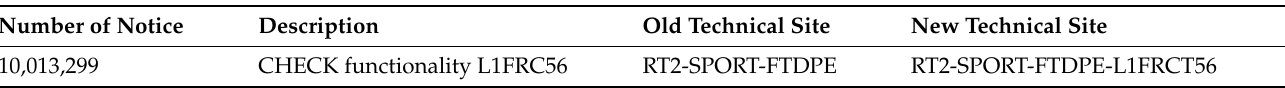
Table 6. Example of reconstruction site using the fourth methodology when the technical site contains